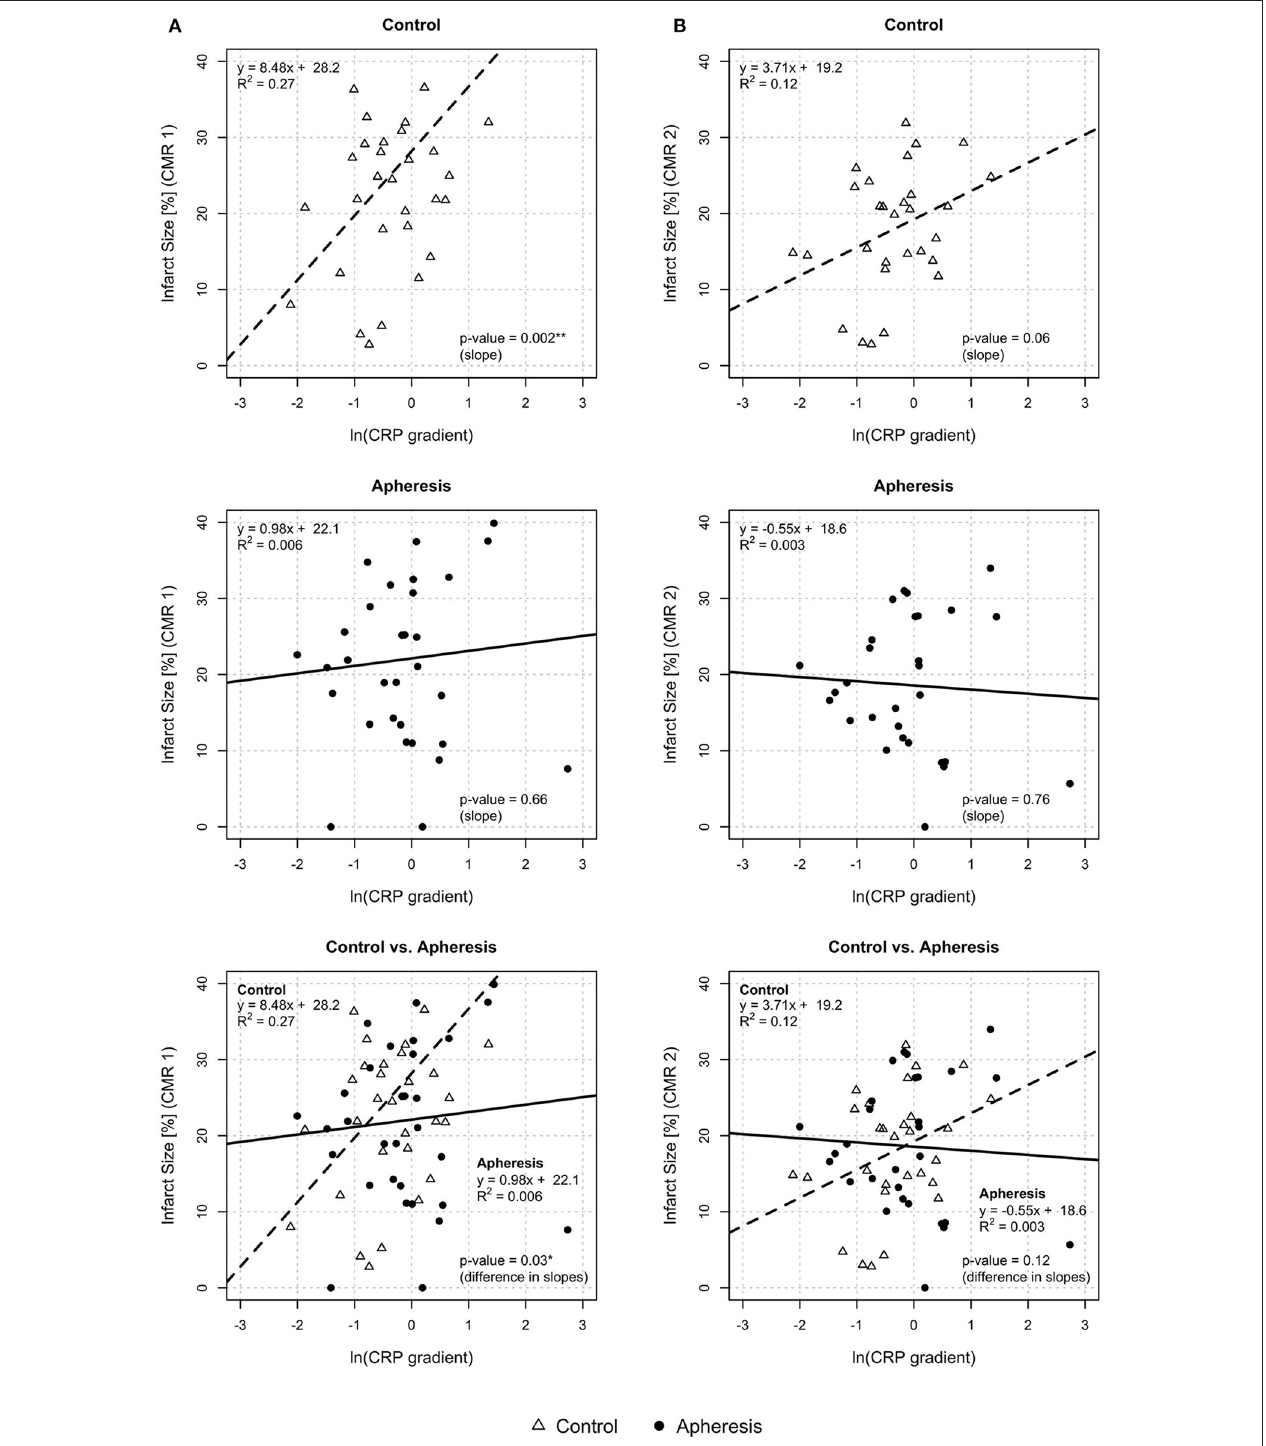
FIGURE 3 | Myocardial infarct size and CRP gradient [ln(CRP gradient)] at CMR1 (A) and CMR2 (B) . CMR1—Control group: Highly significant increase of infarct size with an increase of CRP gradient ( p = 0.002). Increase of infarct size by 8.5% with an increase of ln(CRP gradient) by 1 unit. Apheresis group: Small increase of infarct size with an increase of CRP gradient ( p = 0.66). Importantly, the two linear models differ significantly ( p = 0.03). CMR2—Control group: Non-significant increase of infarct size with an increase of CRP gradient ( p = 0.06). Increase of infarct size by 3.7% with an increase of ln(CRP gradient) by 1 unit. Apheresis group: Small loss of infarct size with an increase of CRP gradient ( p = 0.76). The two linear models differ, but not significantly ( p = 0.12).